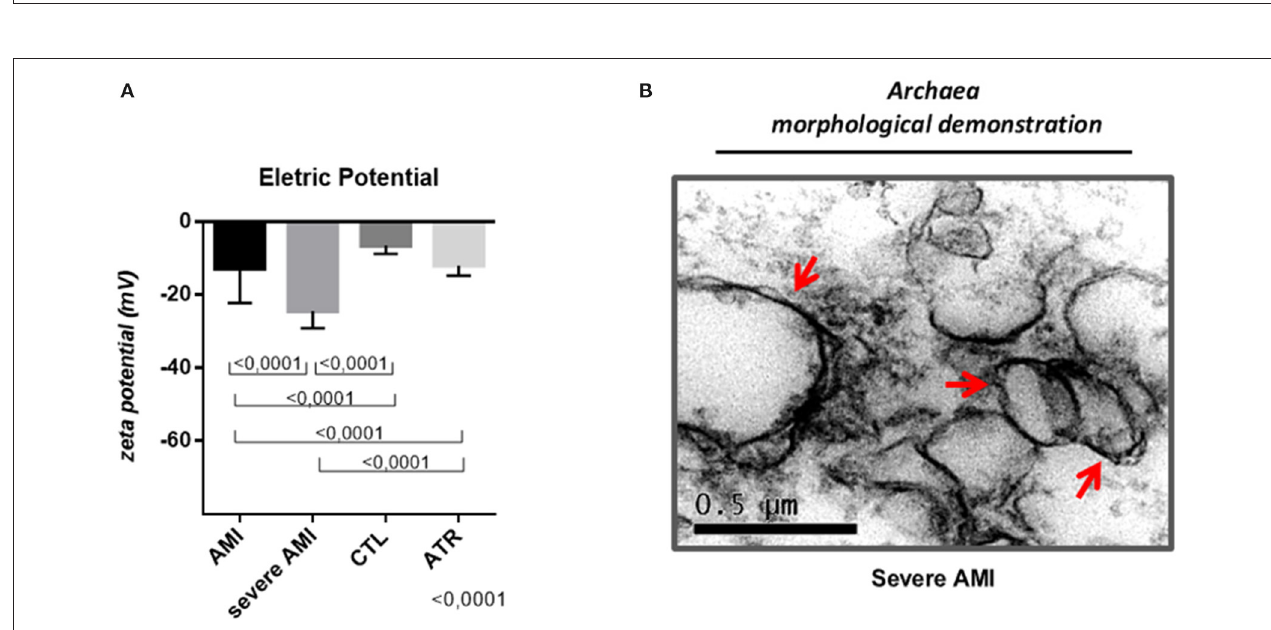
FIGURE 6 | Quantification of the electrical charge of EVs—Zeta Potential. Decreased EVs electrical charge is accompanied by worsening of the evolution of atherosclerotic disease. (A) Infarcted patients, especially those who have a greater amount of pathogenic archaea, exhibit EVs with a highly negative electrical charge. EVs (Exos and MVs) with negative electric charge (mV) (AMI n = 40, severe AMI n = 34, CTL n = 34, ATR n = 40). (B) Demonstration of the morphological characteristic of archaea present in severe AMI. (Data are expressed as the mean and standard deviation). Comparison by ANOVA with Tukey applied as a post-test. Red arrows: Morphological Demonstration of Archaeas by Transmission Electron Microscopy.